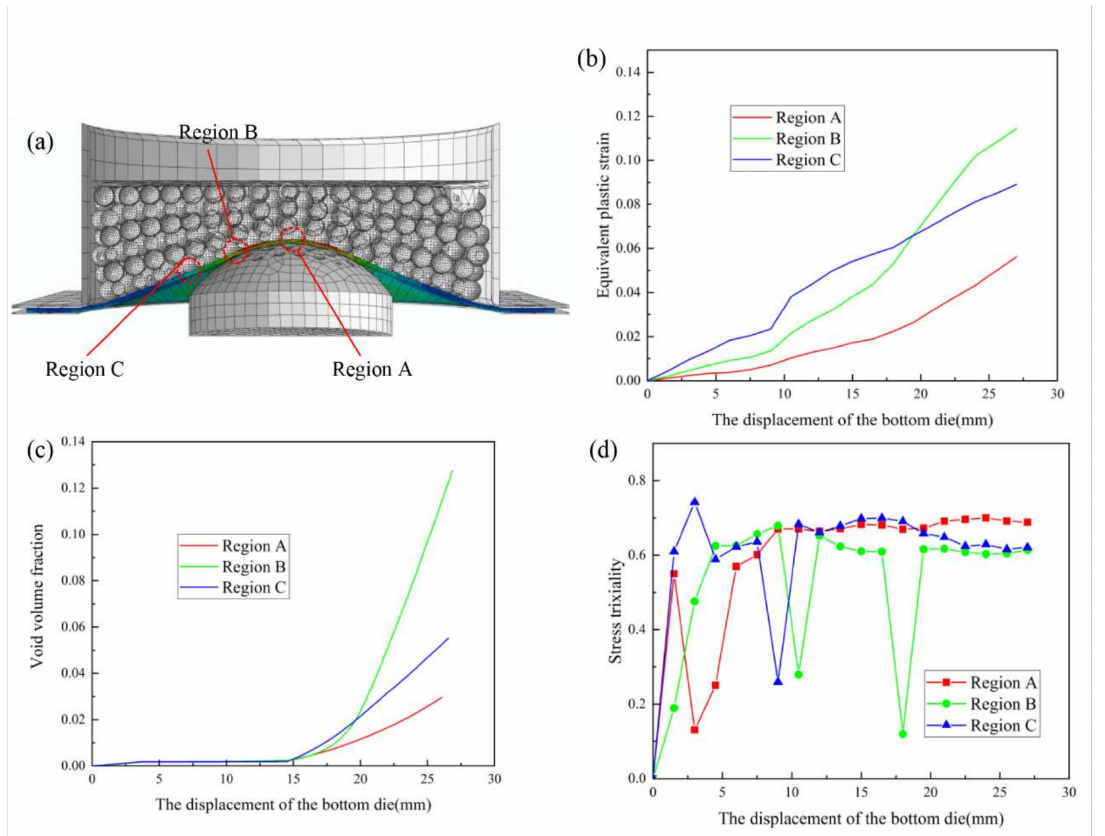
Figure 12. The evolution of different region: ( a ) Schematic diagram of different region; ( b ) The evolution of Equivalent plastic strain; ( c ) The evolution of void volume fraction; ( d ) The evolution of stress trixiality.